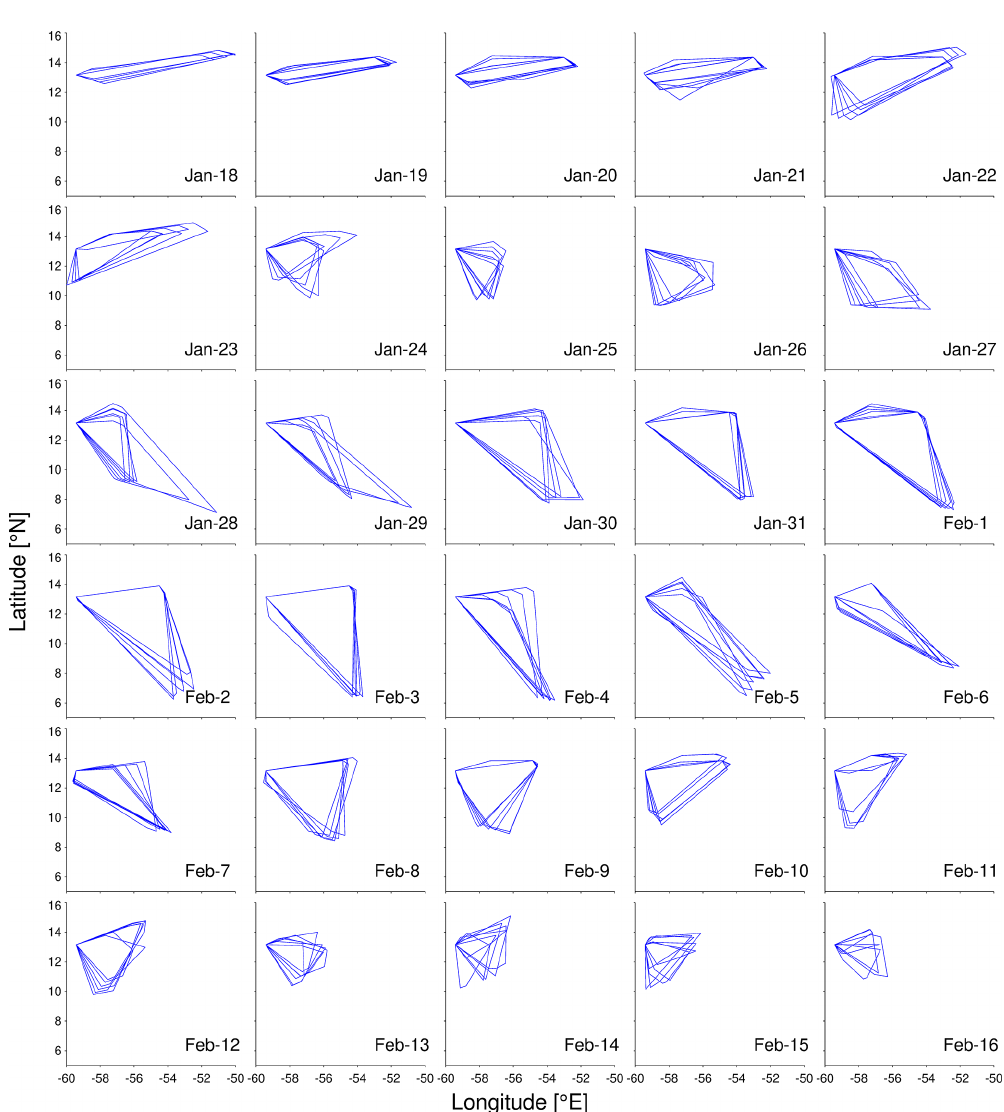
Figure 3. For each day between 18 January and 16 February, 4-hourly polygons mark the outer bounds of the radiosonde network. Polygon vertices correspond to starting locations of either ascending or descending soundings that occurred within ± 2h of a fixed